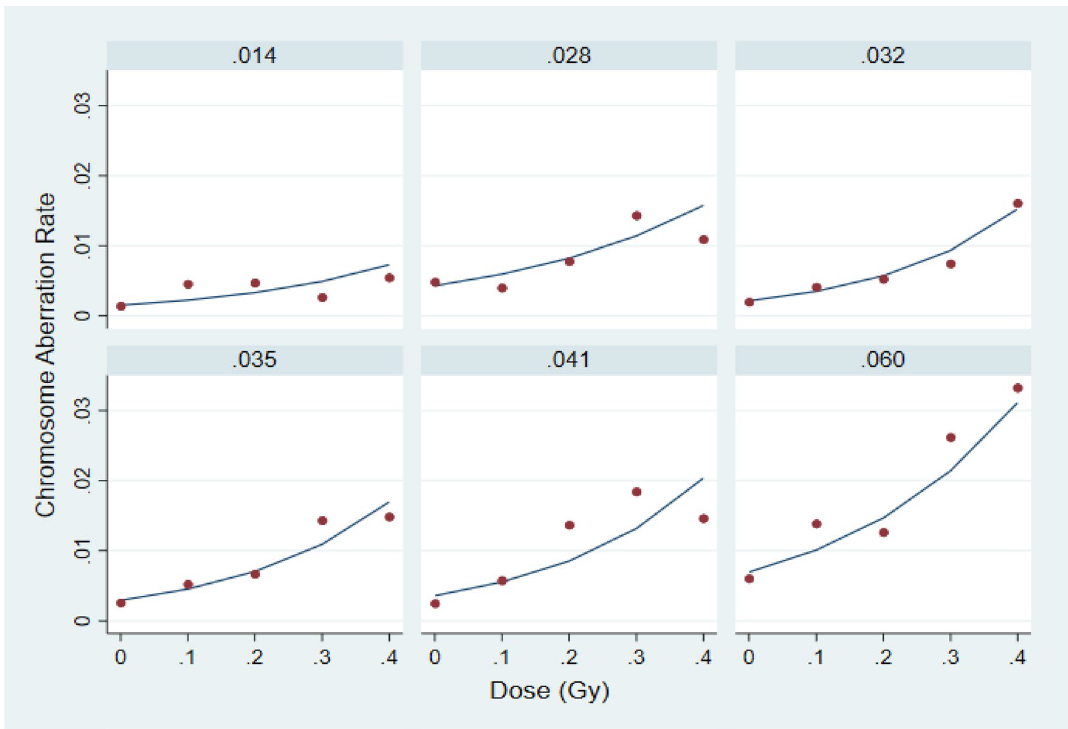
Figure 2. Poisson regression predictions of pre-flight dose response (solid lines) for 6 crewmembers covering the observed range of pre-flight average slopes (values at the top of each section are in the units of CAR per Gy of dose). Observed CARs are plotted as red